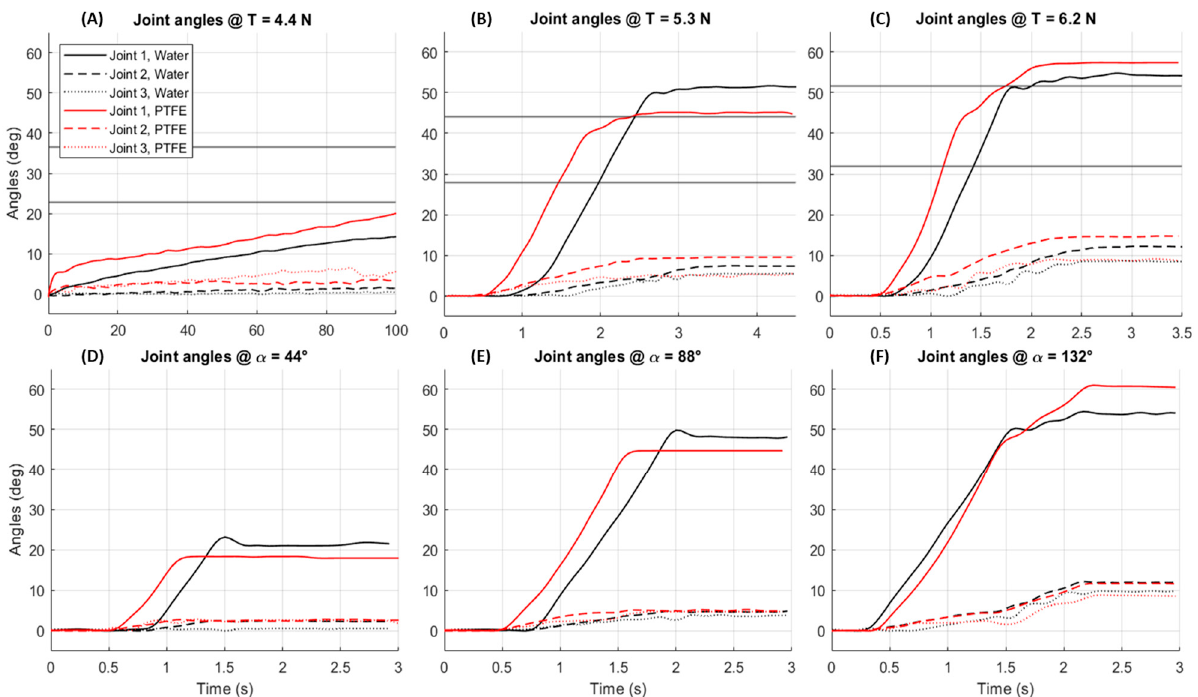
. Table 6. Maximum pull-out force (mean and variance) for three increasing values of activation. Figure 8. Positioning test results with torque-control and position-control modes. Tests in water are plotted in black, and tests on PTFE are plotted in red. Joint angle trajectories for three increasing values of cable tension T = 4.4 N ( A ), T = 5.3 N ( B ), and T = 6.2 N ( C ). Horizontal lines correspond to theoretical values obtained from Equation (1). Joint angle trajectories for three increasing values of motor angle α = 44 ◦ ( D ), α = 88 ◦ ( E ), and α = 132 ◦ ( F ).